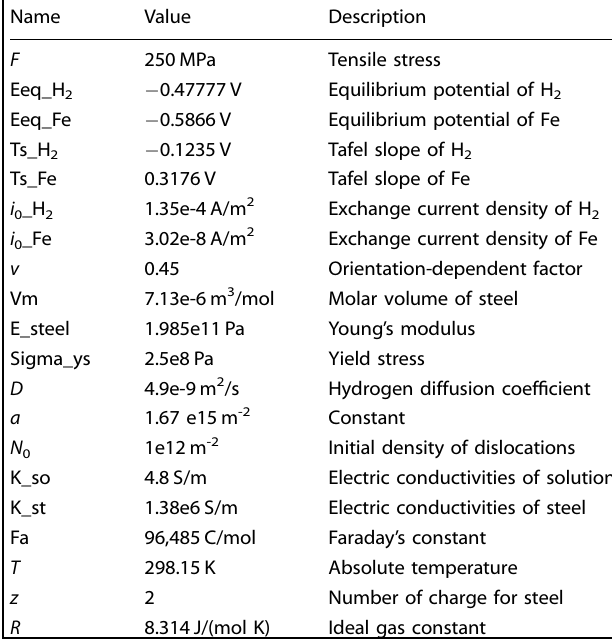
Table 1. Initial electrochemical parameters used in FE simulation. Electrochemical reactions